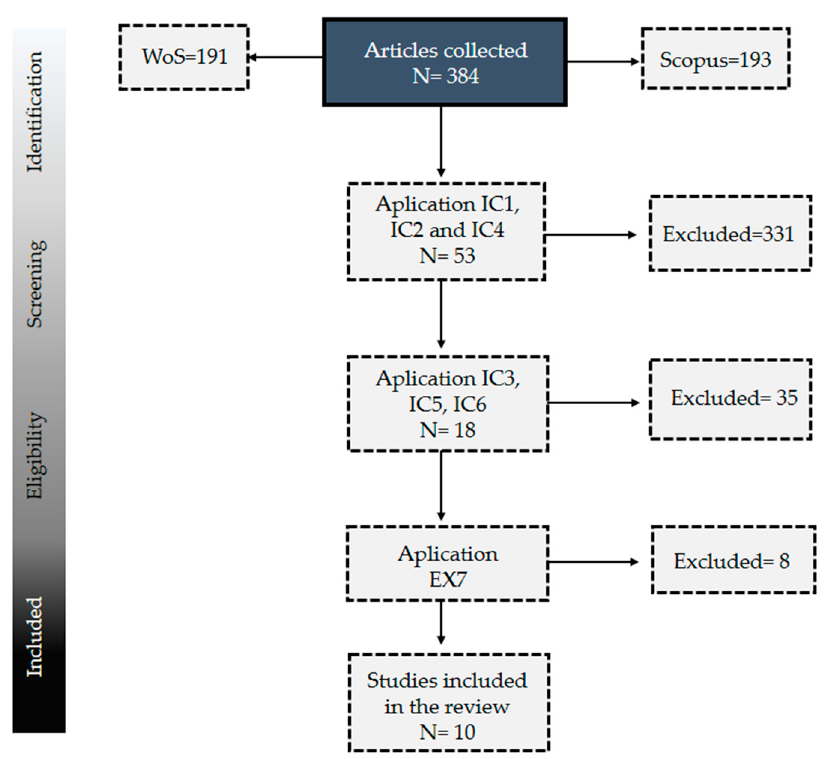
Figure 1. Flowchart of the phases that make up the systematic review.